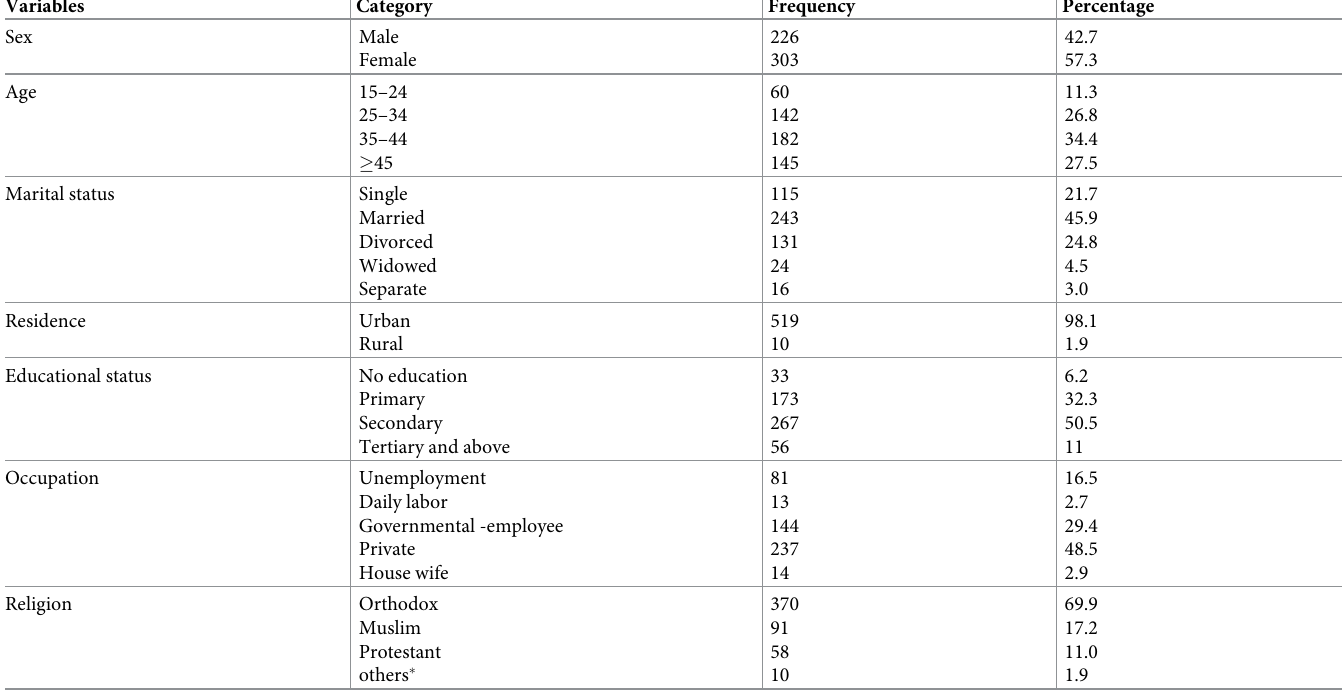
Table 1. Base line socio-demographic characteristics for adult HIV patients on ART in St. peter specialized hospital and Zewditu memorial hospital between Janu- ary 1,2016 and August